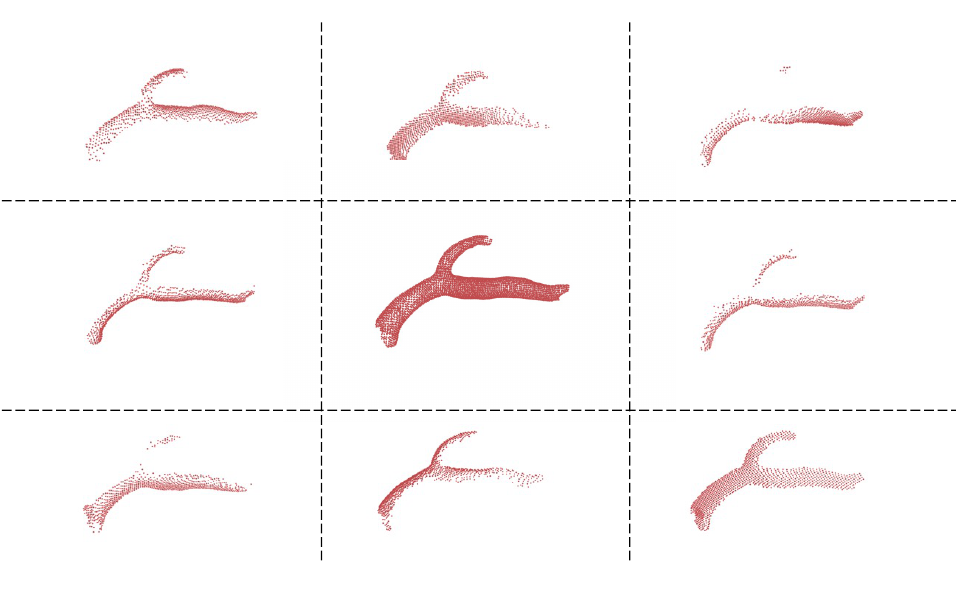
Figure 5. One example of the IntrACompletion dataset. The complete point cloud is shown in the middle, and its 8 different angles partial point clouds are shown to surround